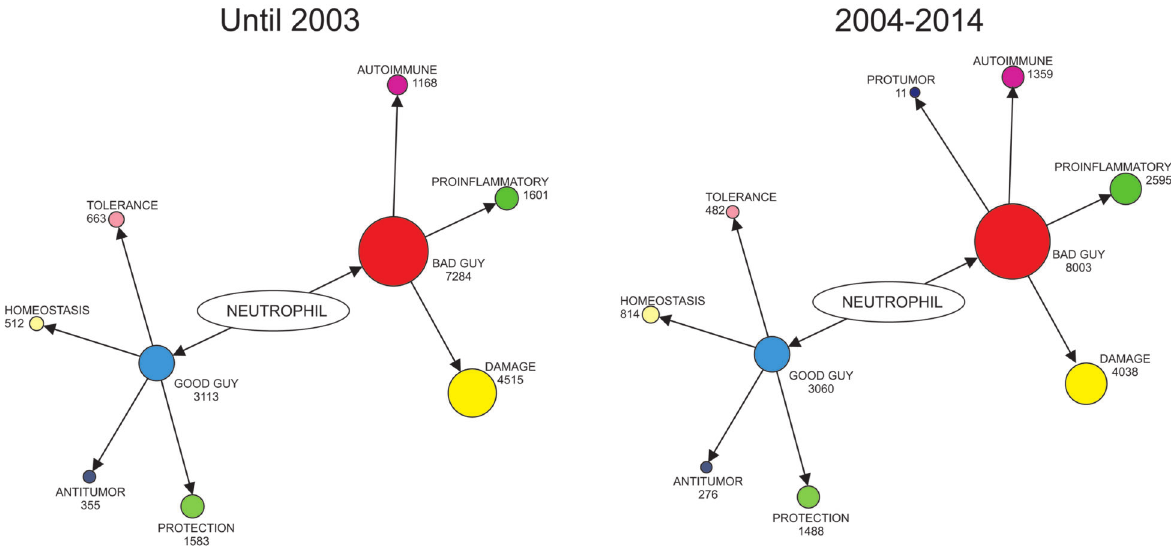
Figure 4. Representative image illustrating the view of neutrophils as ‘‘ bad guys ’’ . Searches of the Medline database (PubMed) using a broad strategy were preformed to identify studies related to ‘‘ good ’’ and ‘‘ bad ’’ neutrophil pro fi les. The number of publications returned in each search was entered into an igraph s library creating the representation depicted. The relationships (or edges) between the terms and neutrophils are presented by arrows and the terms are presented by circles (or nodes). The size of each is proportional to the number of publications returned. On the left side, the graph shows the publications until 2003 and on the right, from 2004 until 2014. Data were collected on November 15, 2014.